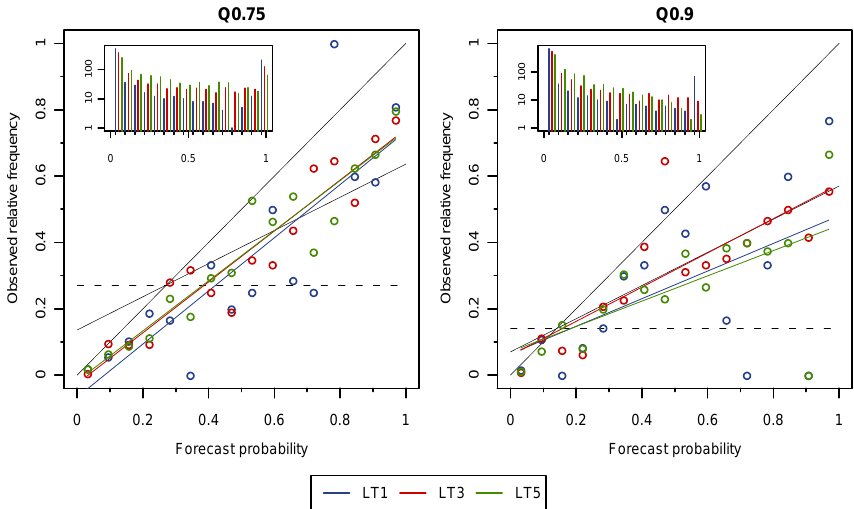
Fig. 7. Reliability diagrams for the daily maximum Sihl discharge in Zurich for the discharge thresholds Q 0 . 75 (left) and Q 0 . 9 (right). The circles indicate the observed frequency of each forecast probability class for lead times of 1, 3 and 5 days (LT1, LT3 and LT5). A linear regression is depicted for each lead time. The sub-plots show the associated refinement